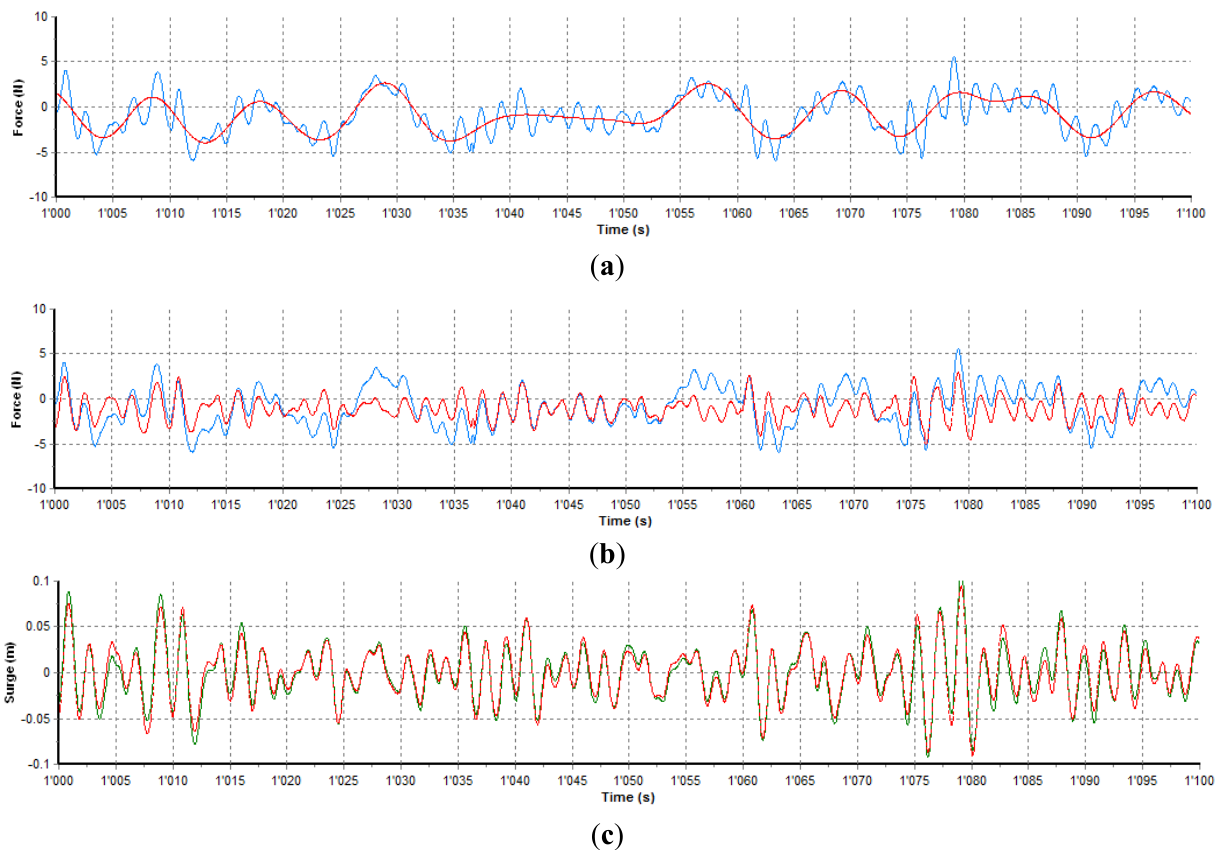
Figure 5. Band-pass filtering of force and surge signals in time domain, for test with k mid, low R , T and S . ( a ) Low frequency component (red) of the recorded force signal c r 100 p 0 (blue); ( b ) high frequency component (red) of the recorded force signal (blue); and ( c ) high frequency component (red) of the recorded surge signal